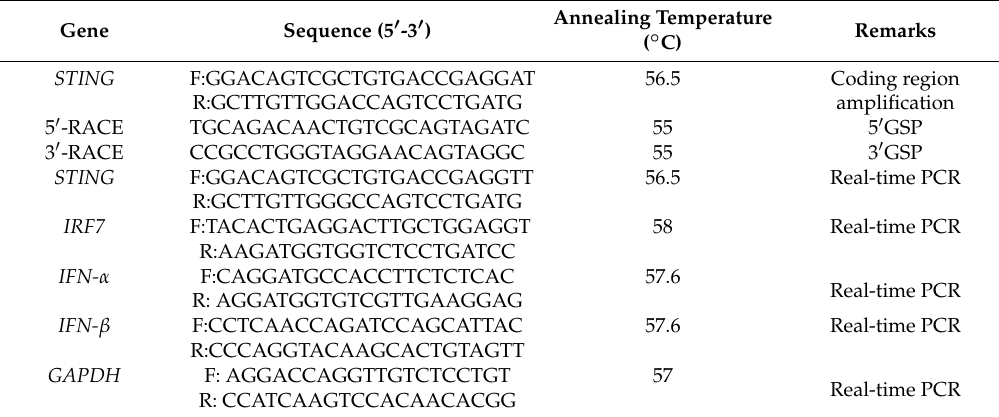
Table 1. Primer sequences for cloning and real-time polymerase chain reaction